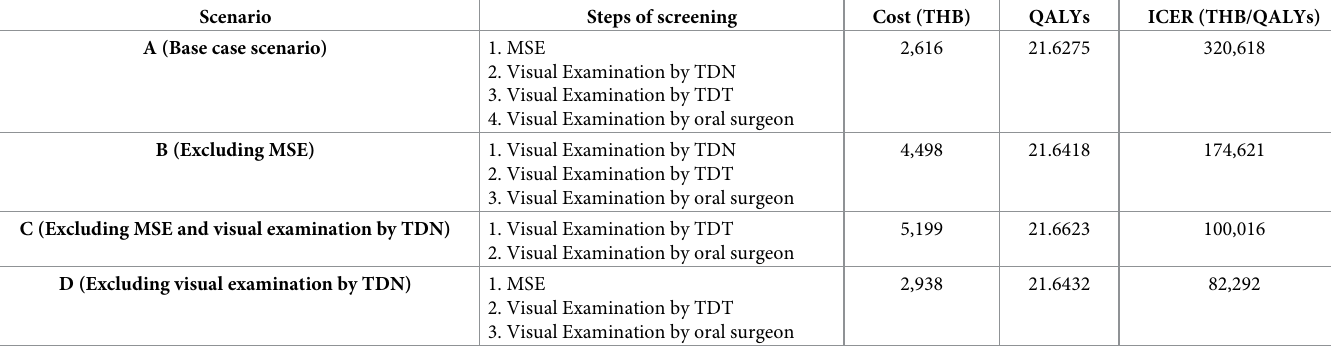
Table 3. Summary of subgroup